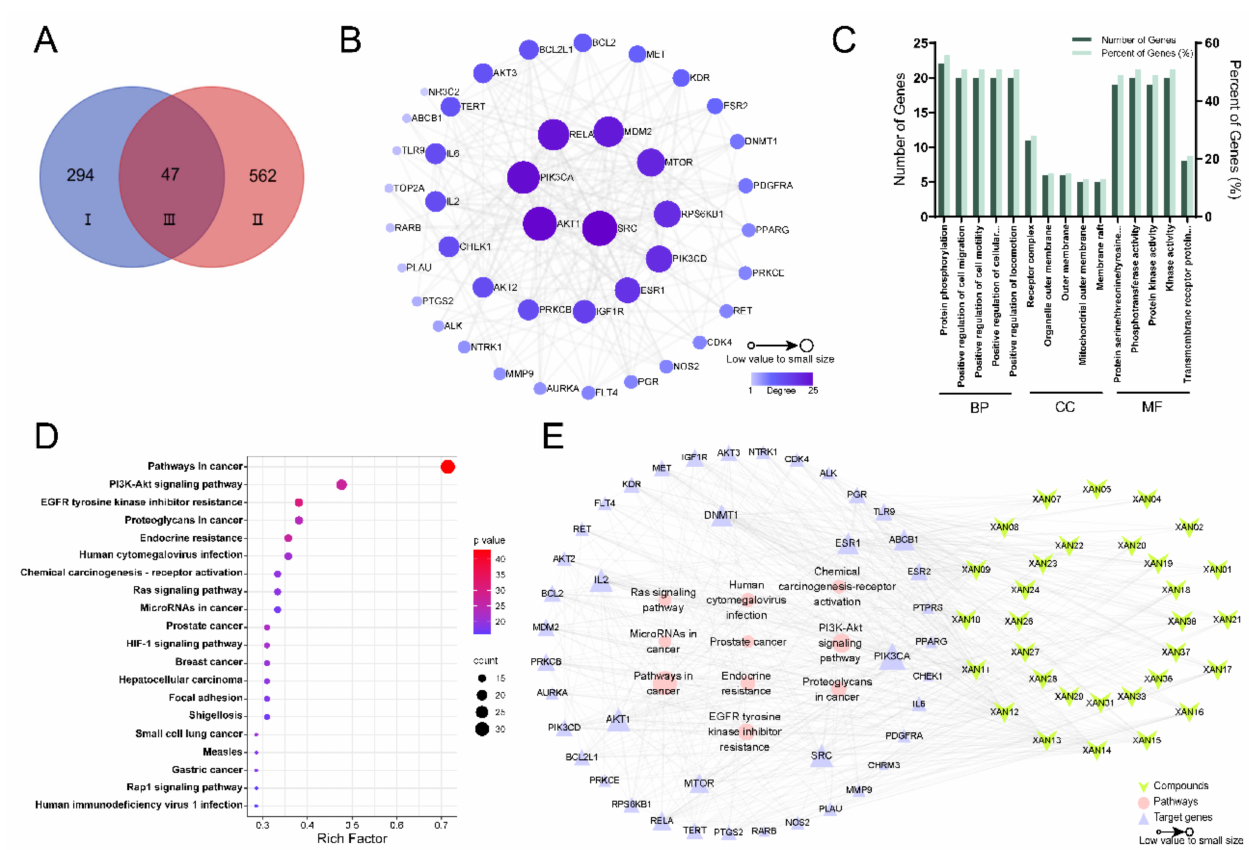
Figure 5. The network pharmacology analysis for the anti-CRC activities of xanthones. ( A ) Venn diagram of the targets of xanthones-CRC (I: targets related to xanthones; II: targets related CRC; III: the intersecting targets for xanthones and CRC); ( B ) PPI network of the intersecting targets for xanthones and CRC. ( C ) Annotation analysis of Gene Ontology; ( D ) The visual results of KEGG signal pathway; ( E ) Component-target-pathway interaction network